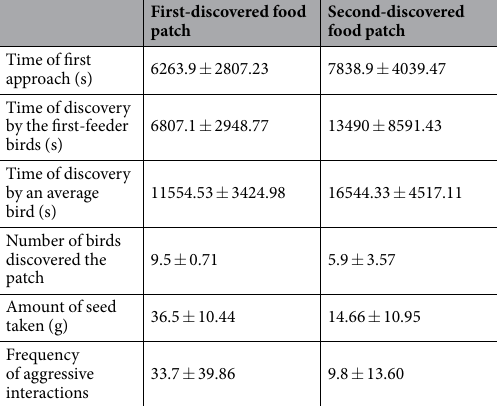
Table 1. Mean ± SD of the investigated parameters at the two food patches in the house sparrow flocks.